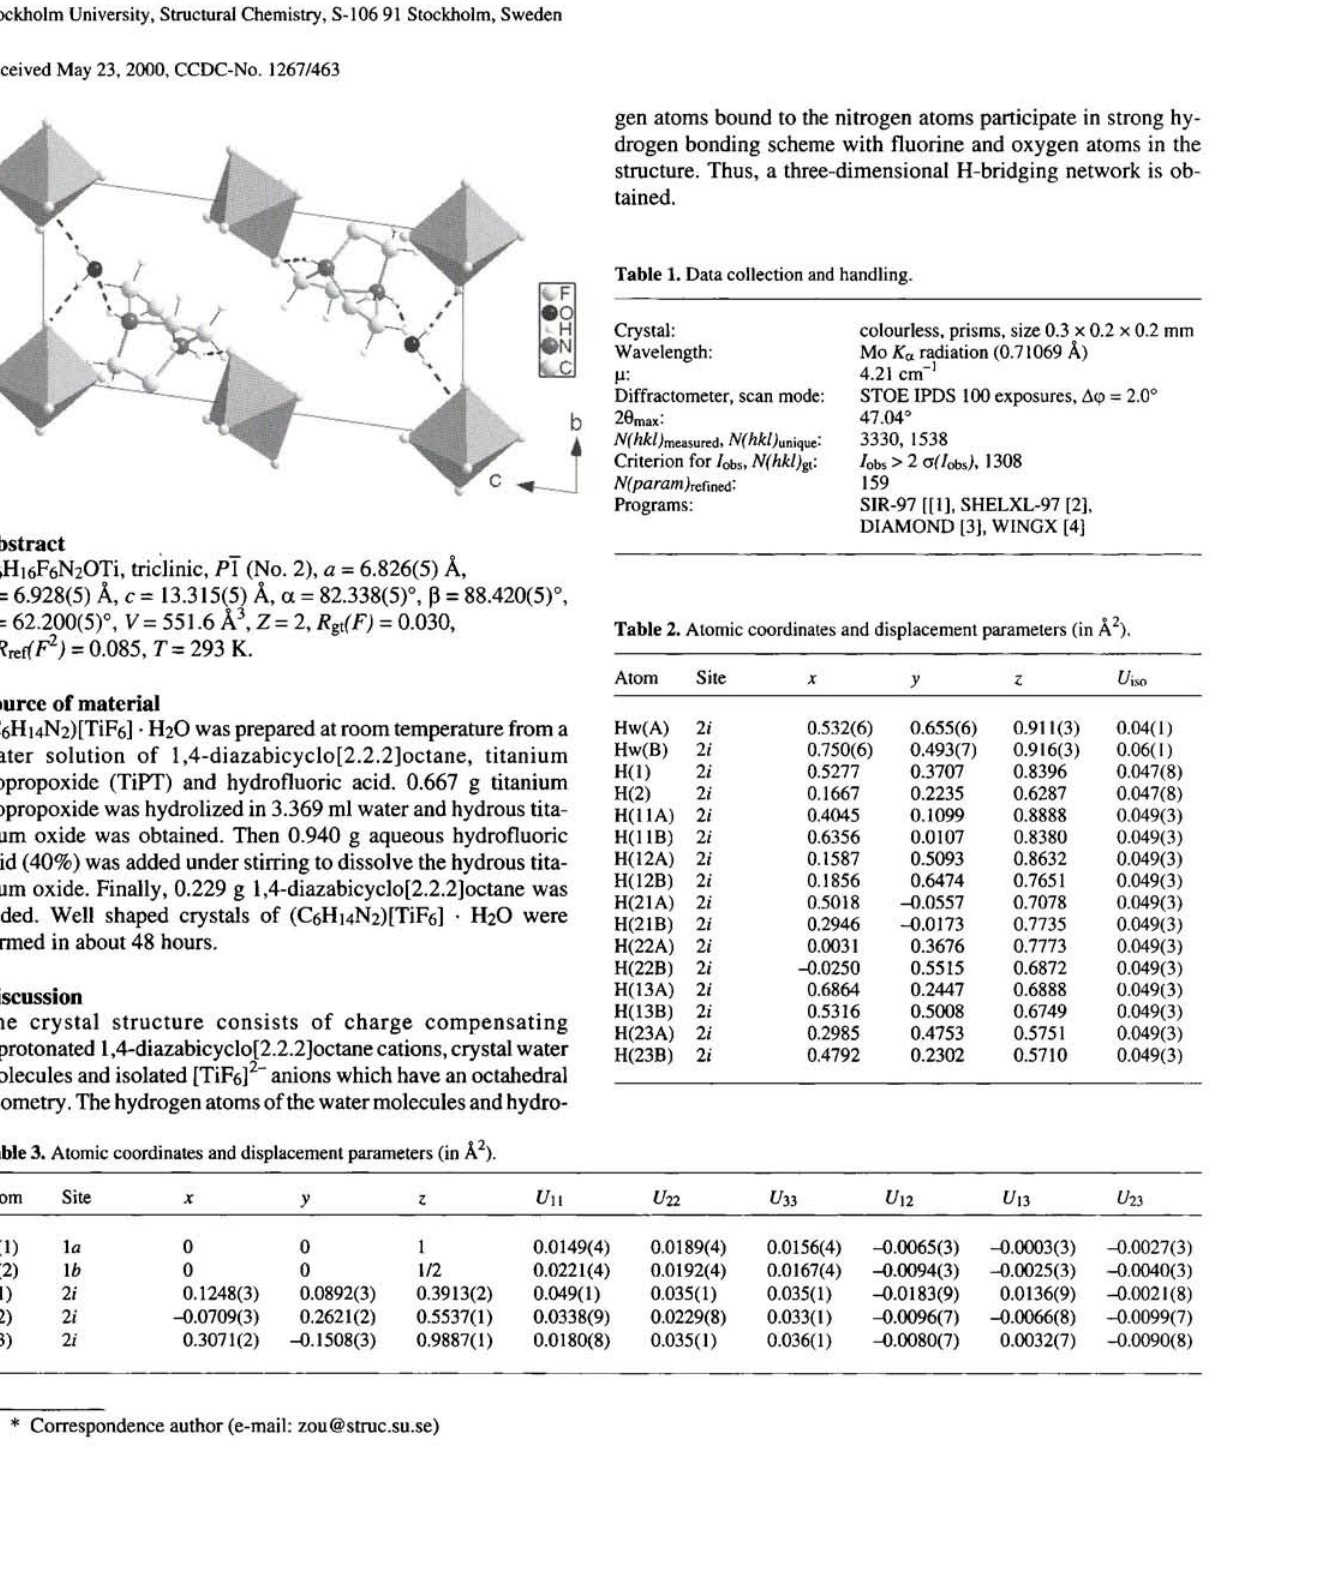
Table 1. Data collection and handling.